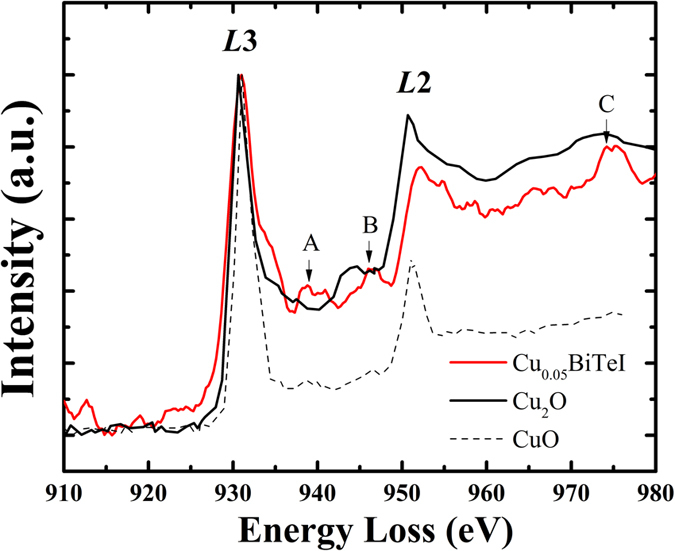
Typical EELS plot of the Cu-L3 and L2 edges for Cu0.05BiTeI sample, compared with spectra of standard Cu2O and CuO references.